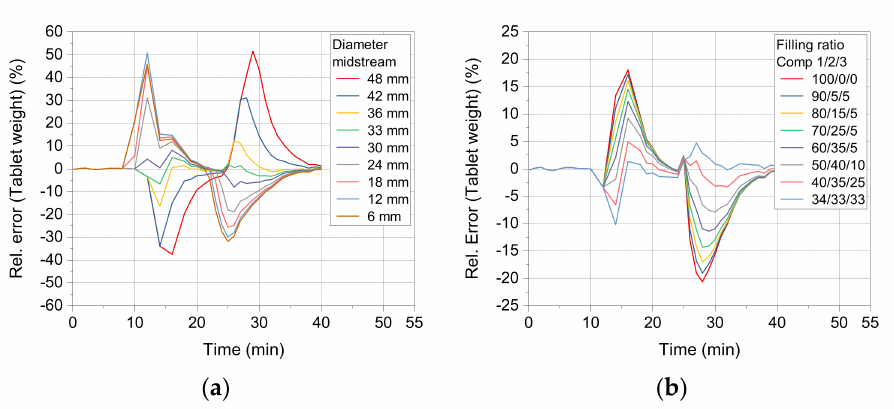
Figure 9. Relative error between simulation and experimental results for ( a ) different midstream diameter settings and ( b ) die filling ratio settings in relation to the tablet weight. Table 6. Relative error of midstream model configuration regarding the tablet weight. Midstream Diameter (mm)